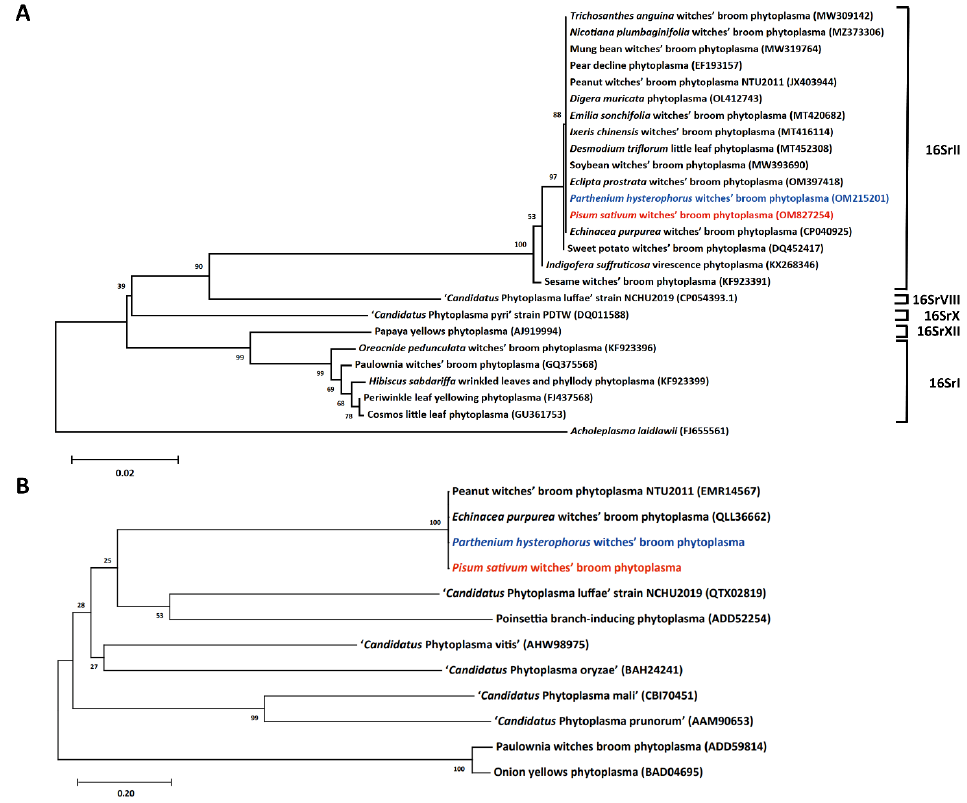
Figure 5. Phylogenies of representative phytoplasmas based on the 16S rRNA genes and Imp proteins. ( A ) The phylogenetic tree was generated based on the R16F2n/R16R2 fragment of the 16S rRNA gene from phytoplasma strains identified in Taiwan. Acholeplasma laidlawii served as an outgroup. ( B ) The phylogenetic tree was generated using phytoplasma Imp homologs. In both panels, the 16S rRNA genes and Imp proteins of Pisum sativum witches’ broom phytoplasma and Parthenium hysterophorus witches’ broom phytoplasma identified in this study are presented in red and blue, respectively. Numbers next to internal branches indicate the bootstrap support levels based on 1000